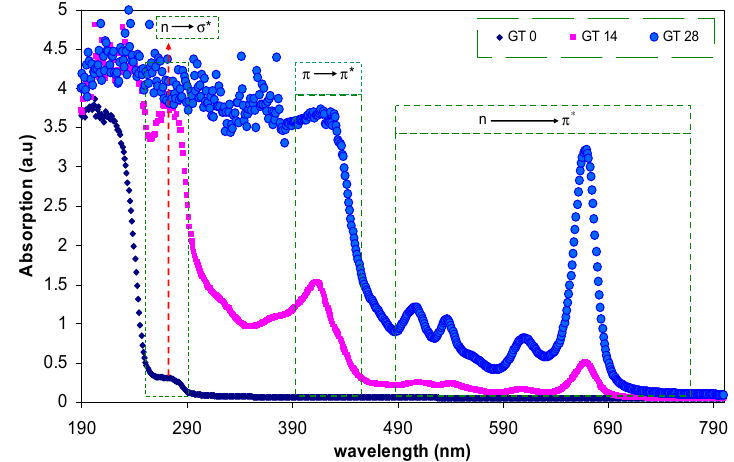
Figure 5. The absorption spectra of pure PMMA and PMMA doped samples.